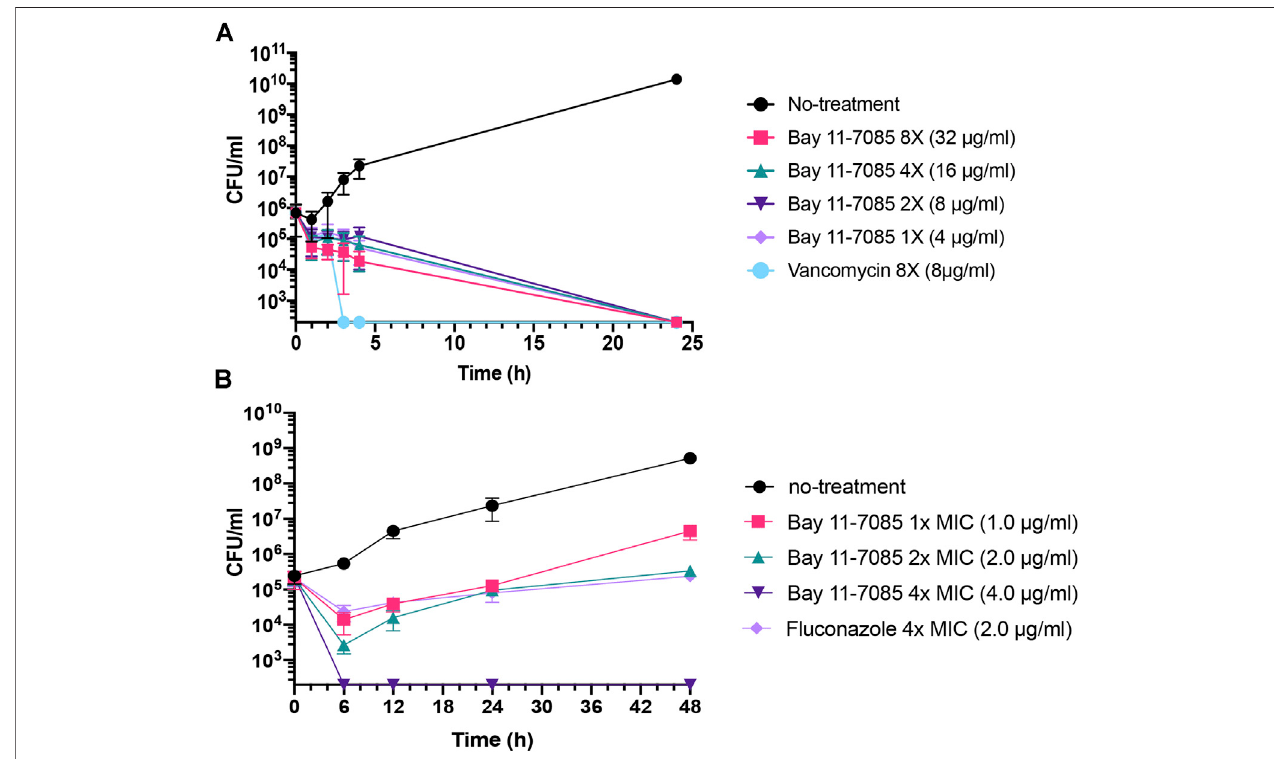
FIGURE2| Bay11-7085isbactericidaltowardMRSAandfungistatictoward C.albicans . (A) MRSAstrainMW2cellsweregrowntologphaseOD 600 0.3 – 0.4from overnight liquid culture. Log phase cells were diluted to 10 6 CFU/ml in various concentration of Bay 11-7085 and 8 μ g/ml of vancomycin as a positive control. (B) Overnight culture of C. albicans strain SC5314 was diluted to ∼ 10 6 CFU/ml and added to 1 × (1 μ g/ml), 2 × (2 μ g/ml) and 4 × (4 μ g/ml) MIC of Bay 11-7085. Fluconazole was used as a positive control at 4 × MIC (2.0 μ g/ml). Samples were collected at various time points, serially diluted, and plated to measure total CFU/mL. ( n (cid:2) 3, ±